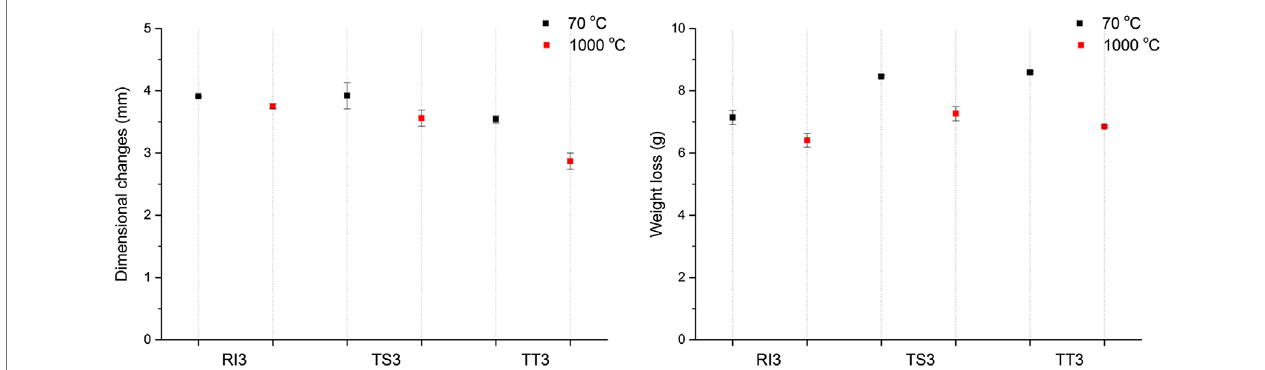
FIGURE 3 | Changes in sample dimensions of the alkali-activated foams investigated, expressed in length and weight